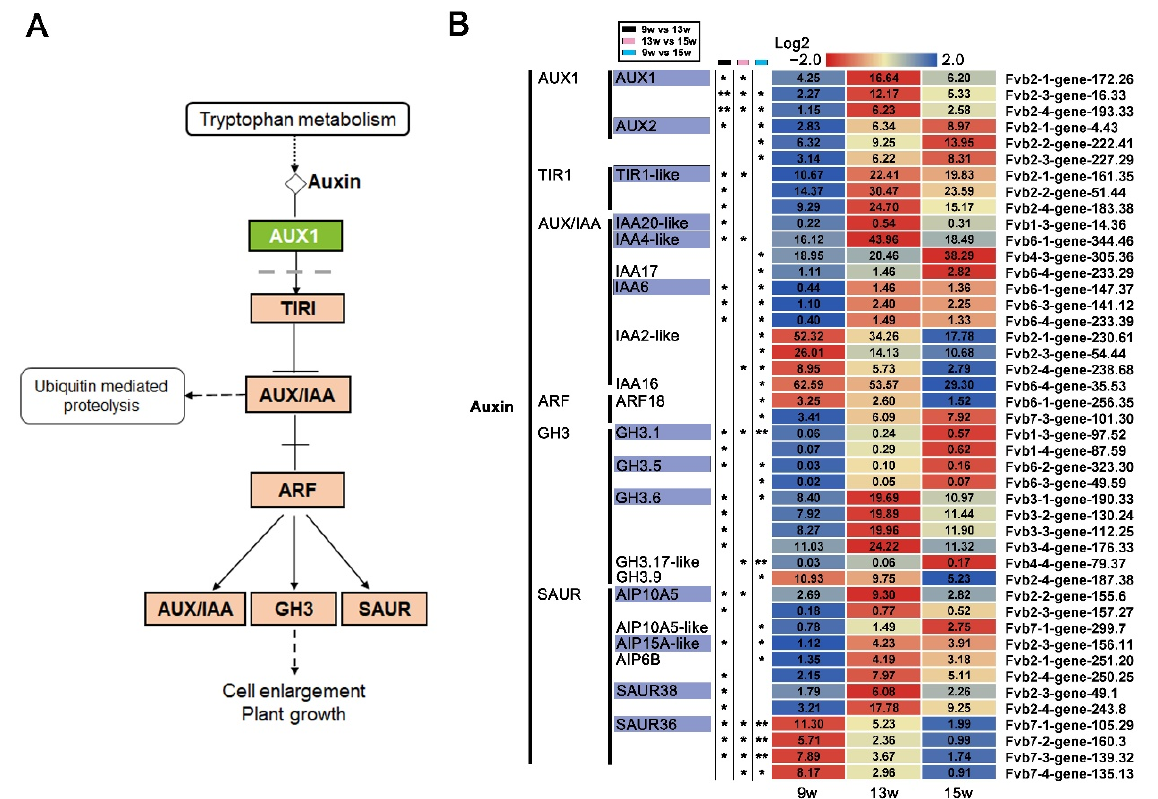
Figure 7. DEGs involved in auxin signaling pathways. ( A ) Auxin signal transduction pathways by referring to the KO04075 pathway in KEGG enrichment analysis. ( B ) Heatmaps showing the relative expression of DEGs involved in the auxin. The purple boxes indicate the genes in which expression was significantly changed by 9 w vs. 13 w. 9 w: vegetative stage, 13 w: shifts to reproductive stage at gene level, 15 w: reproductive stage. The column with the black boxes represents the student’s t test analysis of DEGs by 9 w vs. 13 w. The column with the pink boxes represents the student’s t test analysis of DEGs by 13 w vs. 15 w; The column with the blue boxes represents the student’s t test analysis of DEGs by 9 w vs. 15 w. (* |Log2FC| ≥ 1, p < 0.05. ** |Log2FC| ≥ 2, p < 0.01).